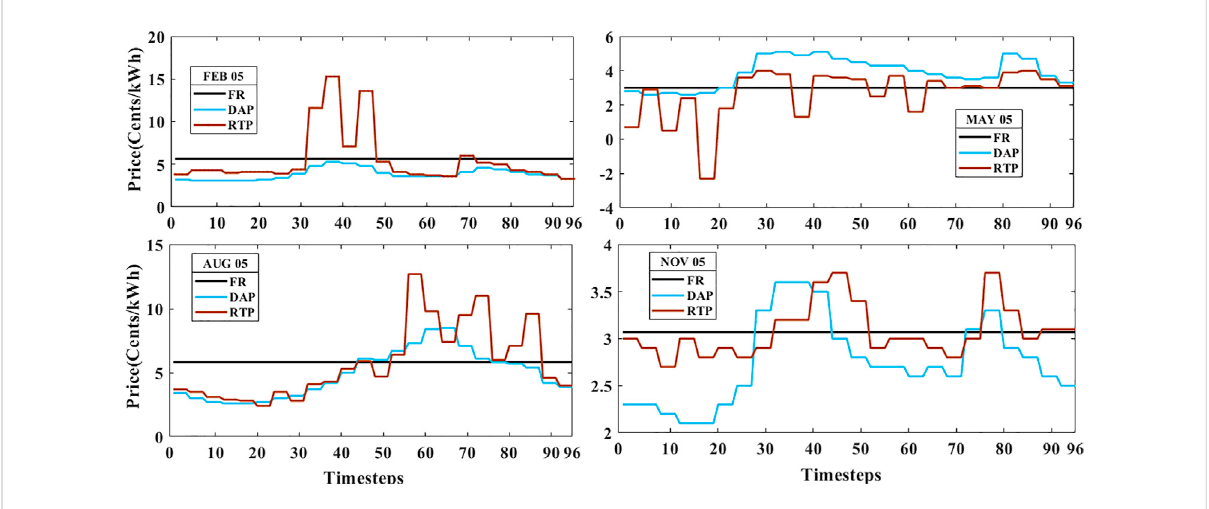
FIGURE 4 Price pro fi le of all the seasons and